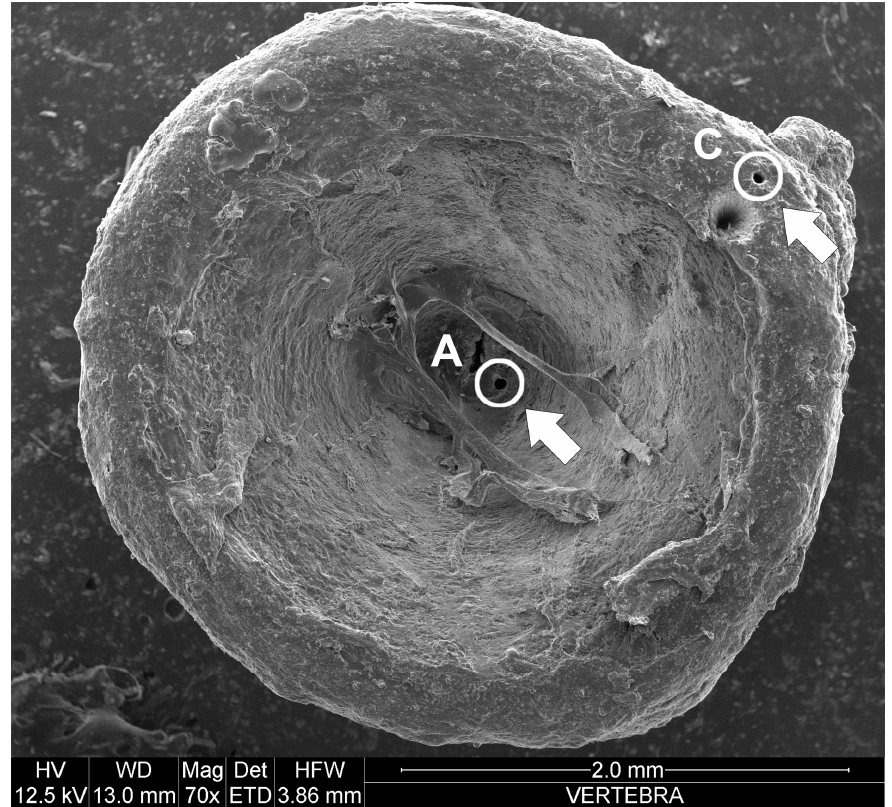
Figure 2. Vertebra of S. canicula showing the two perforations: one close to the center (point A) and one close to the distal part (point C), to analyze the concentration of trace elements in two different stages of the biological cycle of sharks. Circles and arrows indicate the positions of points A and C.